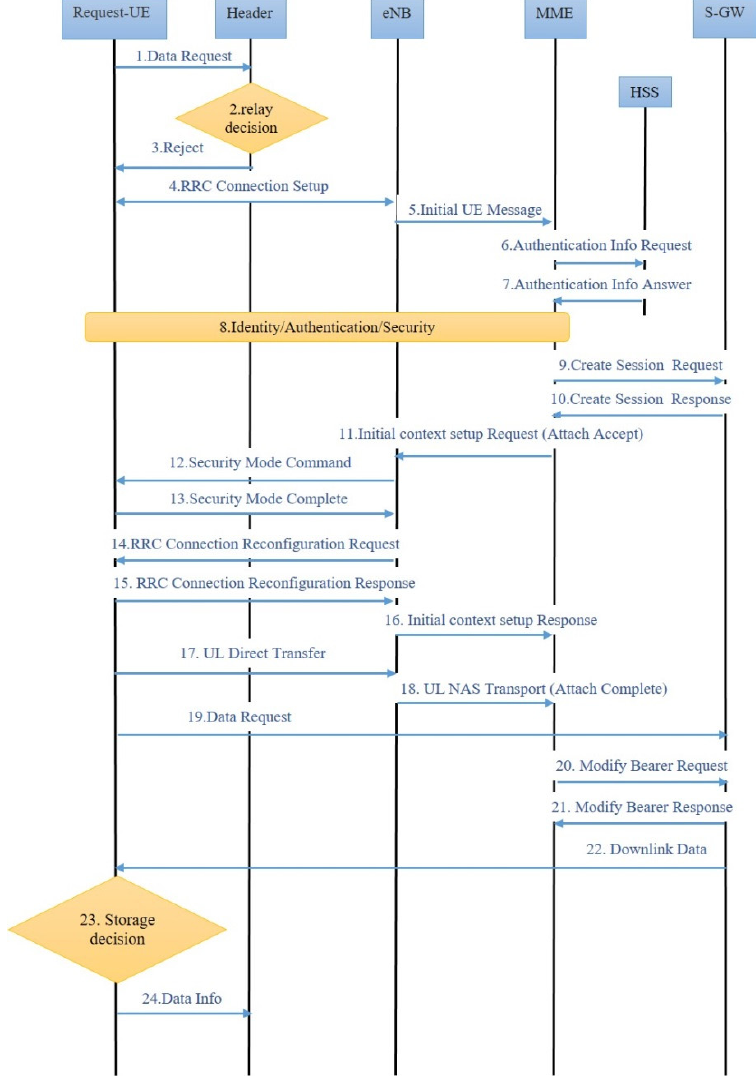
Figure 6. Signaling diagram for downloading content from the core network.